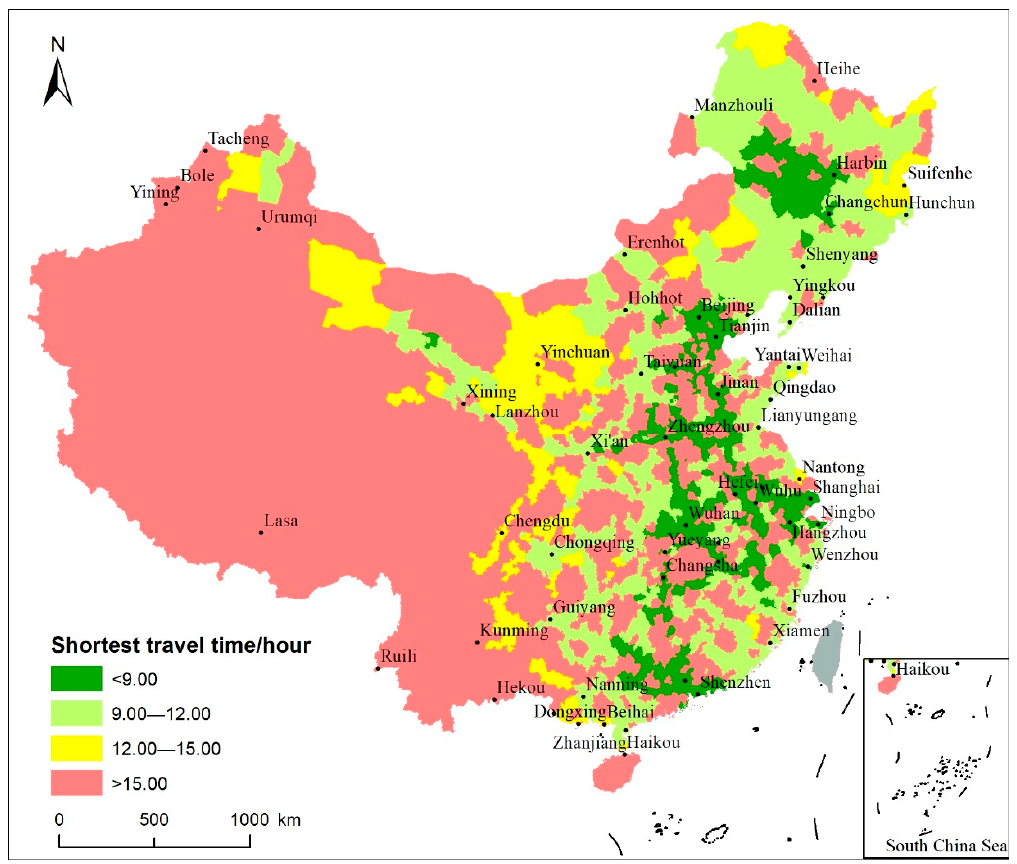
Figure 4. Spatial pattern of the shortest travel time by railway of China in 2015.